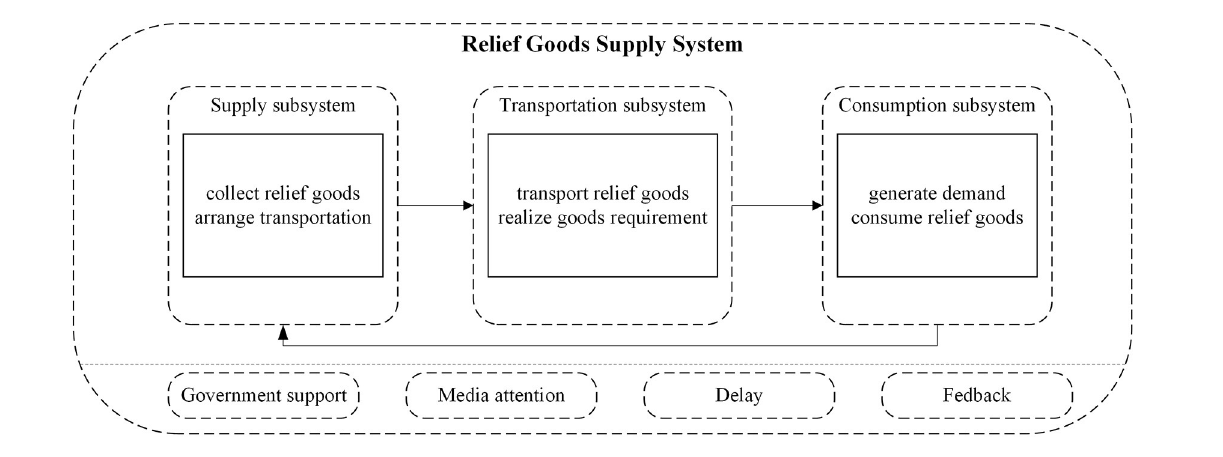
FIGURE2 Supply system framework.